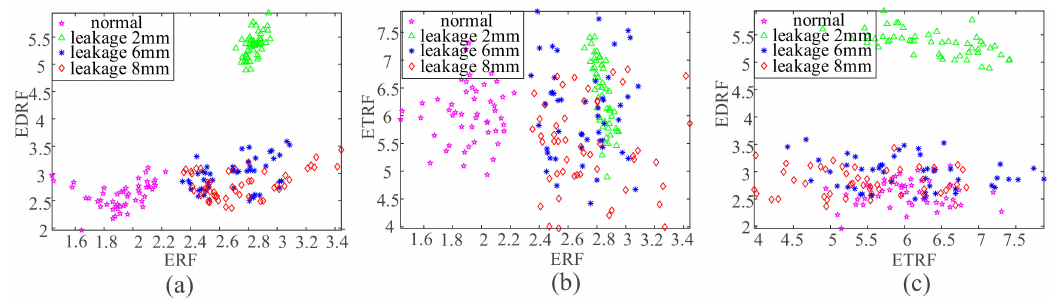
Figure 13. SVM classification e ff ect of response Cis; ( a – c ) are the classification e ff ect of ERF and EDRF, ERF and ETRF as well as ETRF and EDRF as characteristic indicators, respectively.